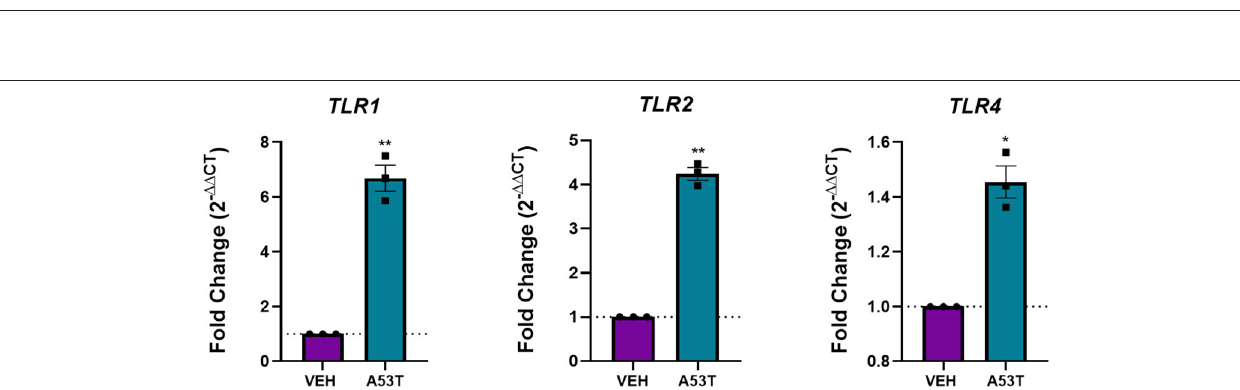
FIGURE 2 | A53T alters microglial morphology. (A) Microglia were treated with 1 µ g/mL misfolded A53T or vehicle (VEH) for 24h and Iba1 immunocytochemistry (green) was used to visualize the cells. Nuclei were counterstained with DAPI (blue). Enlarged microglia (white box) are shown to the right. (B) Consistent with a visual change, A53T exposure led to a change in morphological parameters (cell body area, whole cell area, Feret ratio, and roundness) compared to vehicle treatment; VEH n = 180 cells and A53T n = 138 cells. Values are reported as mean ± SEM, using an unpaired Student’s t -test; **** P ≤ 0.0001.